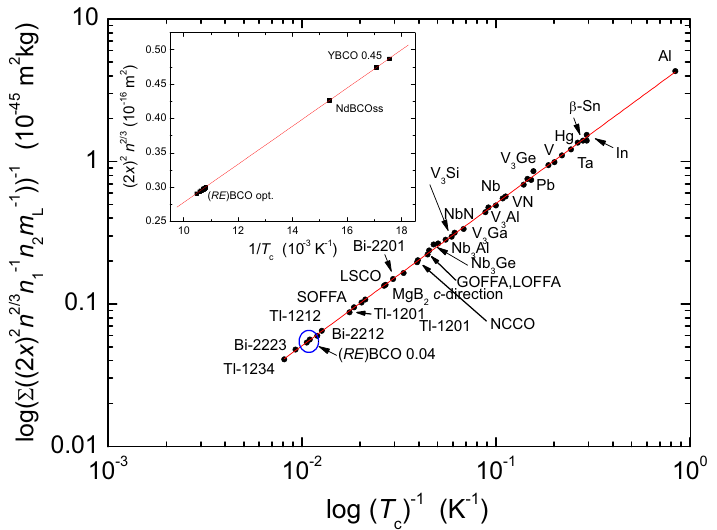
Figure 7. Roeser–Huber plot for various superconductors. The Roeser–Huber line ( ) is shown in red, and the various superconducting materials are indicated as • . The blue circle gives the position of all ( RE )BCO superconductors with optimum oxygen content. SOFFA is the abbrevi- ation for SmO 1 − δ F δ FeAs, the IBS superconductor with the highest T c , GOFFA, and LOFFA are Gd/LaO 1 − ∆ F ∆ FeAs and LSCO is the abbreviation for (La, Sr)CuO 4 . NCCO stands for Nd 2 CeCuO 4 , which is an n-type superconductor. Tl-1201, Tl-1212, and Tl-1234 are members of the Tl-based HTSc family with equivalent Cu-O-planes, and Bi-2201, Bi-2212, and Bi-2223 are members of the Bi-based HTSc family. The inset presents the data calculated here (see also Table 1) in more